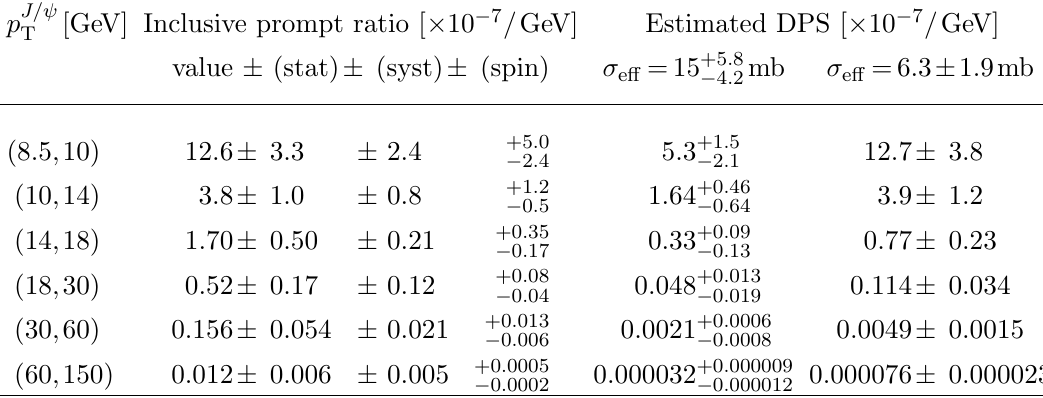
= d p T for prompt J= J= + W (cid:6)